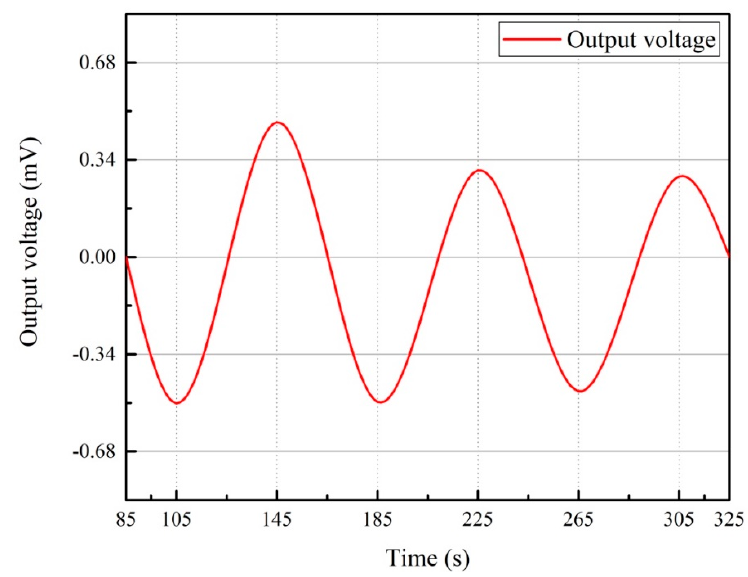
10 of 12 Figure 10. Three-point bending test: measured peak-to-peak output voltage. Because the bending stress clearly correlates with the output voltage, the curve was fitted by taking the extreme value. We fit the output voltage value to a curve, which could facilitate the observation of the change of the output voltage during the bending test and predict the future trend. The preset displacement was reached after 85 s. The average output peak voltage |𝑉(cid:3365) (cid:2926)(cid:2926) | = 0.51 mV was measured during cyclic bending with 80 s per cycle. Additionally, since the piezoelectric material generates an alternating voltage (Figure 11), the relationship between voltage and time can be written as follows: